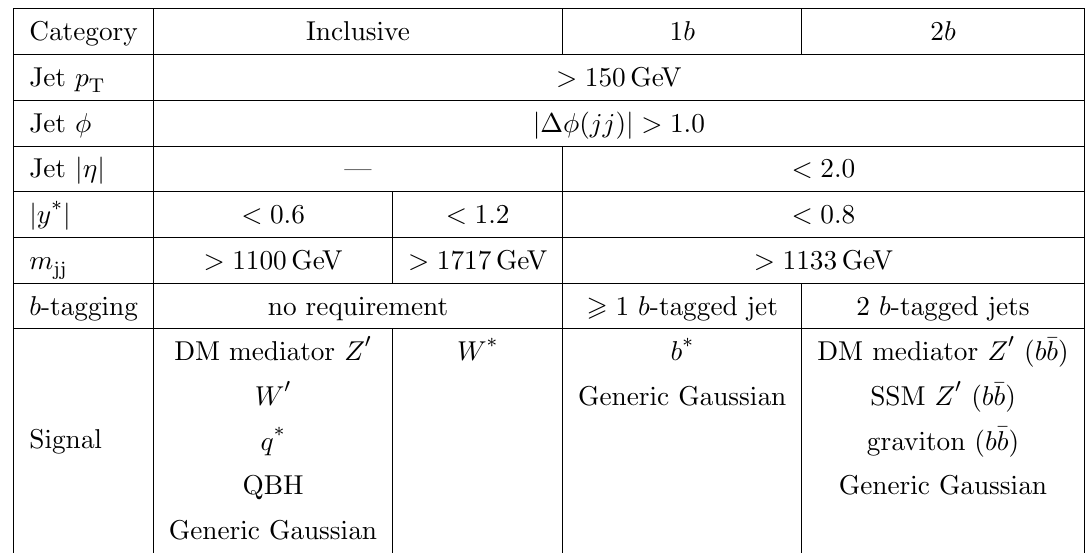
Table 1 . Summary of the event selection requirements and benchmark signals being tested in each analysis category. Only the two jets with highest p of the m lower bounds also depend on the jet energy resolution jj